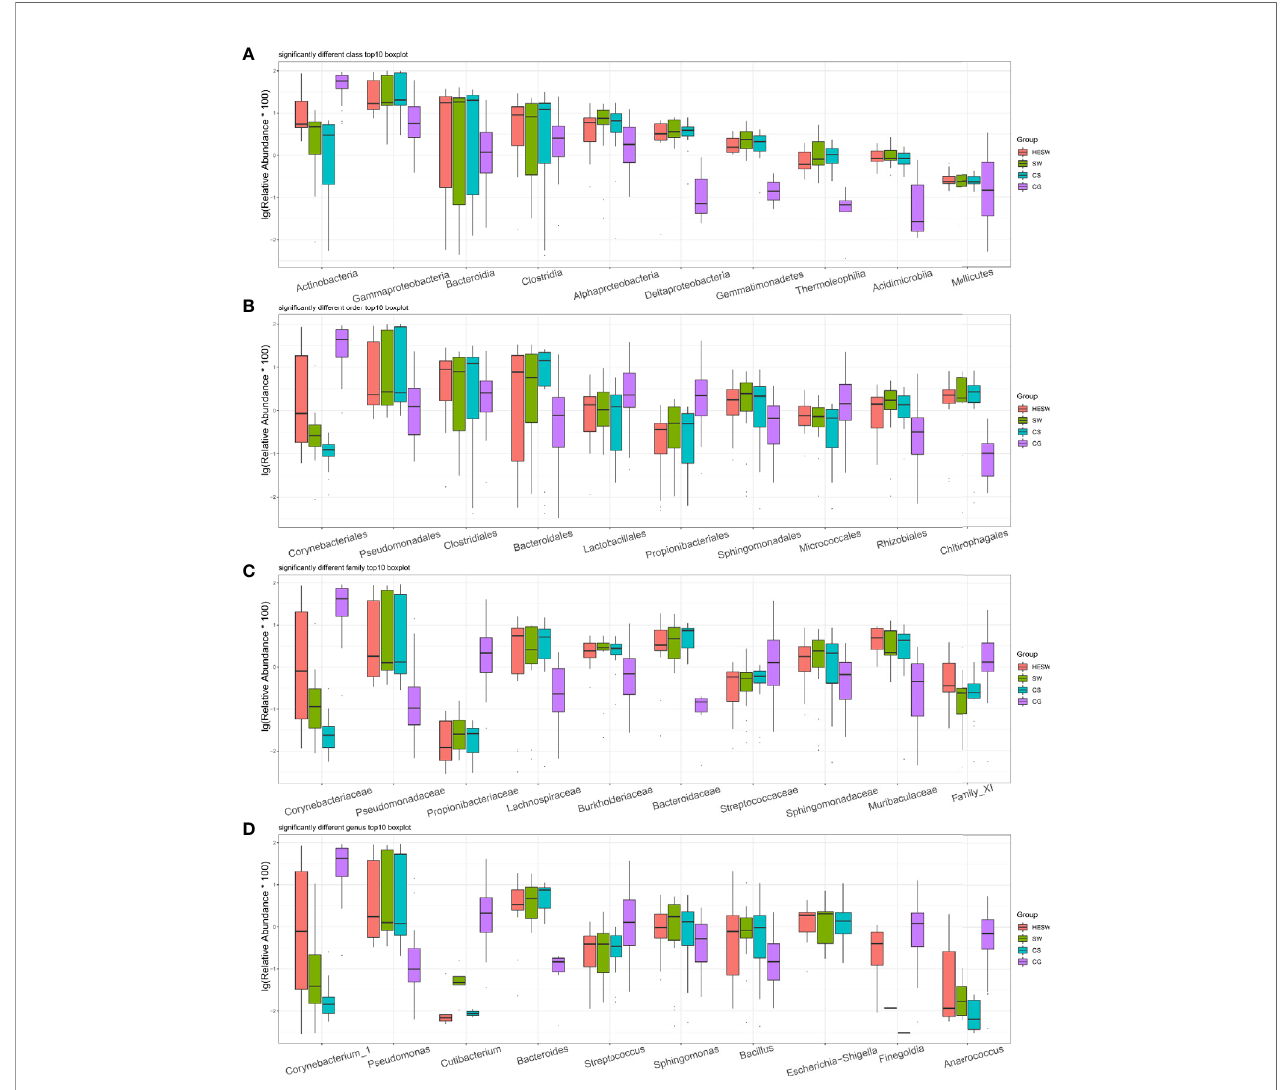
FIGURE 4 | Top 10 taxa with signi fi cant difference at the levels of class, order, family, and genus. (A) At the class level, Actinobacteria signi fi cantly decreased and Gammaproteobacteria signi fi cantly increased in BK patients ’ ocular microbiota. (B – D) At the levels of order, family, and genus, Corynebacter signi fi cantly decreased, while Pseudomonas , Bacteroides , and Escherichia-Shigella signi fi cantly increased in BK patients ’ ocular microbiota (HESW, conjunctival swabs from the healthy eyes of BK patients; SW, conjunctival swabs from the diseased eyes of BK patients; CS, corneal scrapings from the diseased eyes of BK